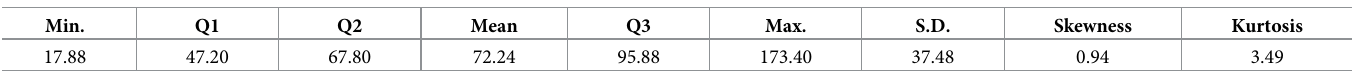
Table 8. Descriptive statistics of ball bearing